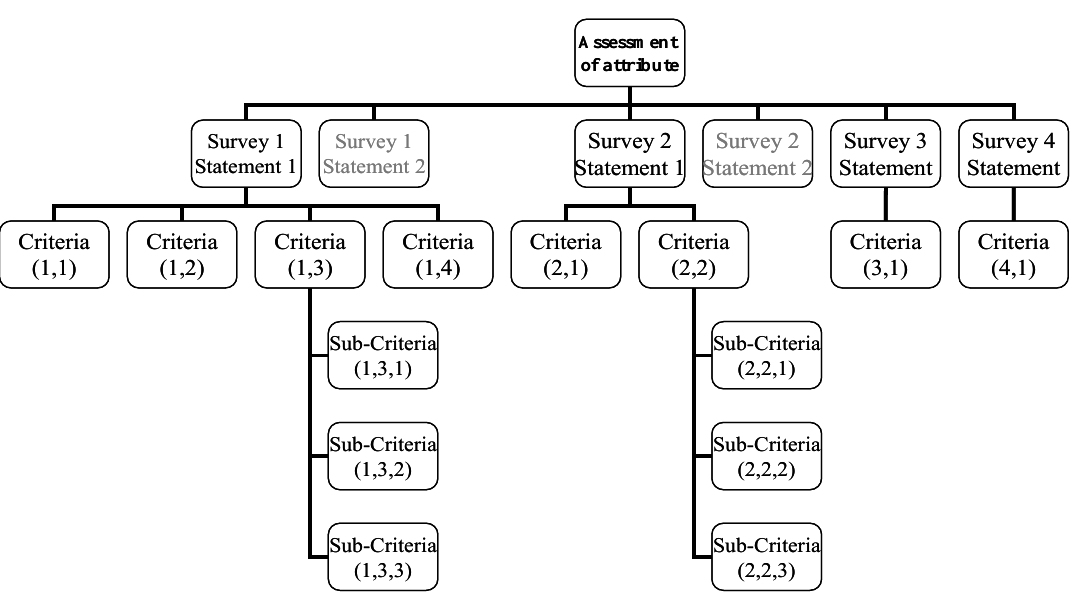
Fig. 1. A general hierarchical structure for attribute